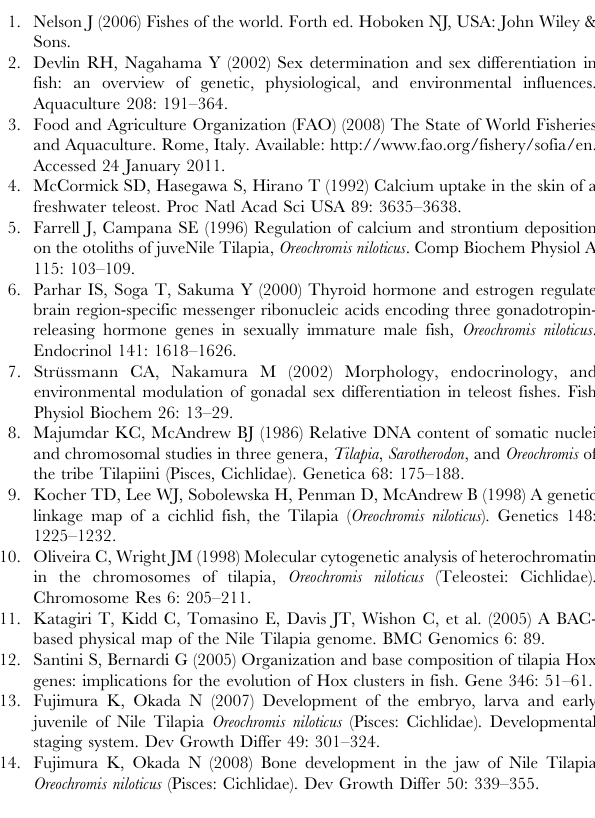
Figure S5 Repetitive elements around vasa gene loci. Fragments of repetitive elements were shown as colored boxes for (A) 38M07, (B) 71H03 and (C) 72C07. Black arrow indicates the coding region of vasa gene. Boxes A–B, C–D and E–F correspond to those of Figures 5, 7, 8, S3 and S4. Fragments of the long interspersed element (LINE) Expander (also known as Rex3 ) were found at the breakpoints in 38M07 and 71H03. (TIF) Table S1 Predicted exons of 38M07 vasa gene. (XLS) Table S2 Predicted exons of 71H03 vasa gene. (XLS) Table S3 Predicted exons of 72C07 vasa gene. (XLS) Table S4 Predicted exons of mRNA sequences, which are deposited on GenBank.